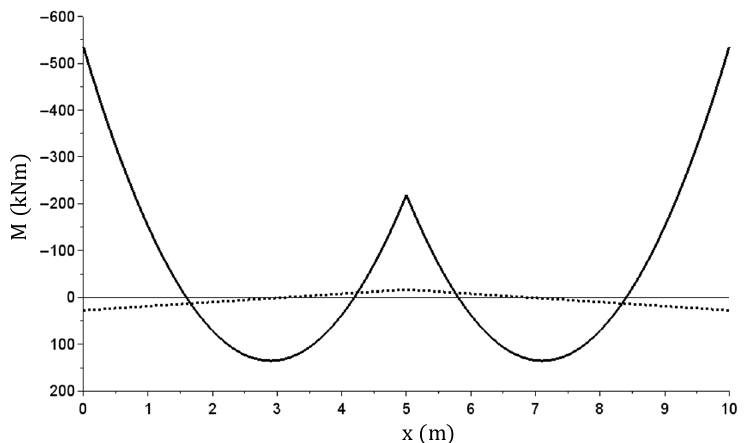
Figure 24. The M(x) (kNm) bending moment graph—at maximum and after relief.